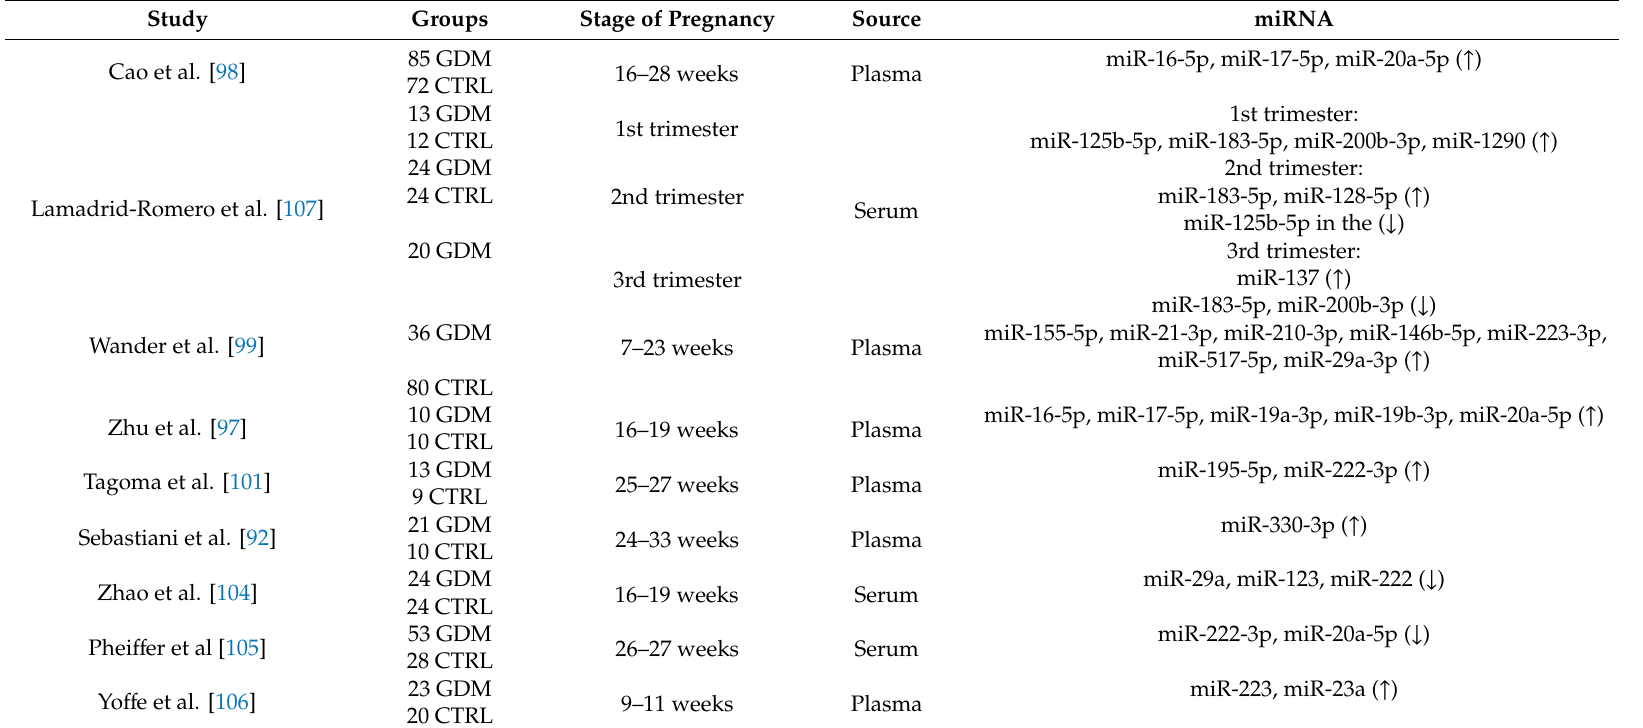
Table 1. Studies that evaluated circulating miRNAs in